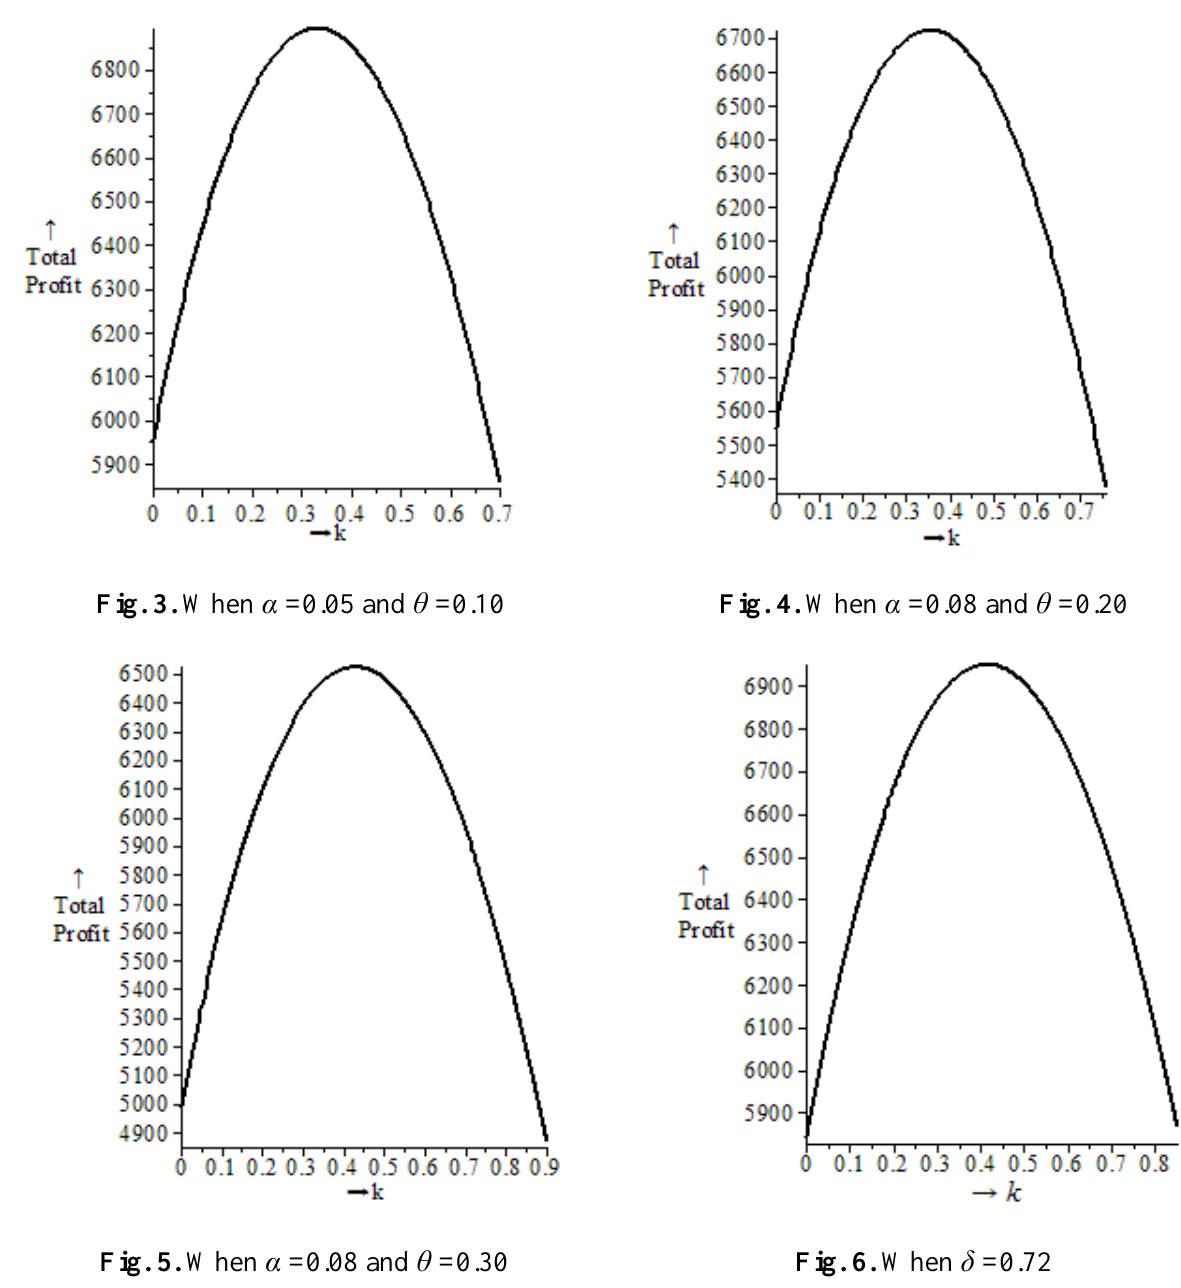
Fig. 5. When α =0.08 and θ =0.30 Fig. 6. When δ